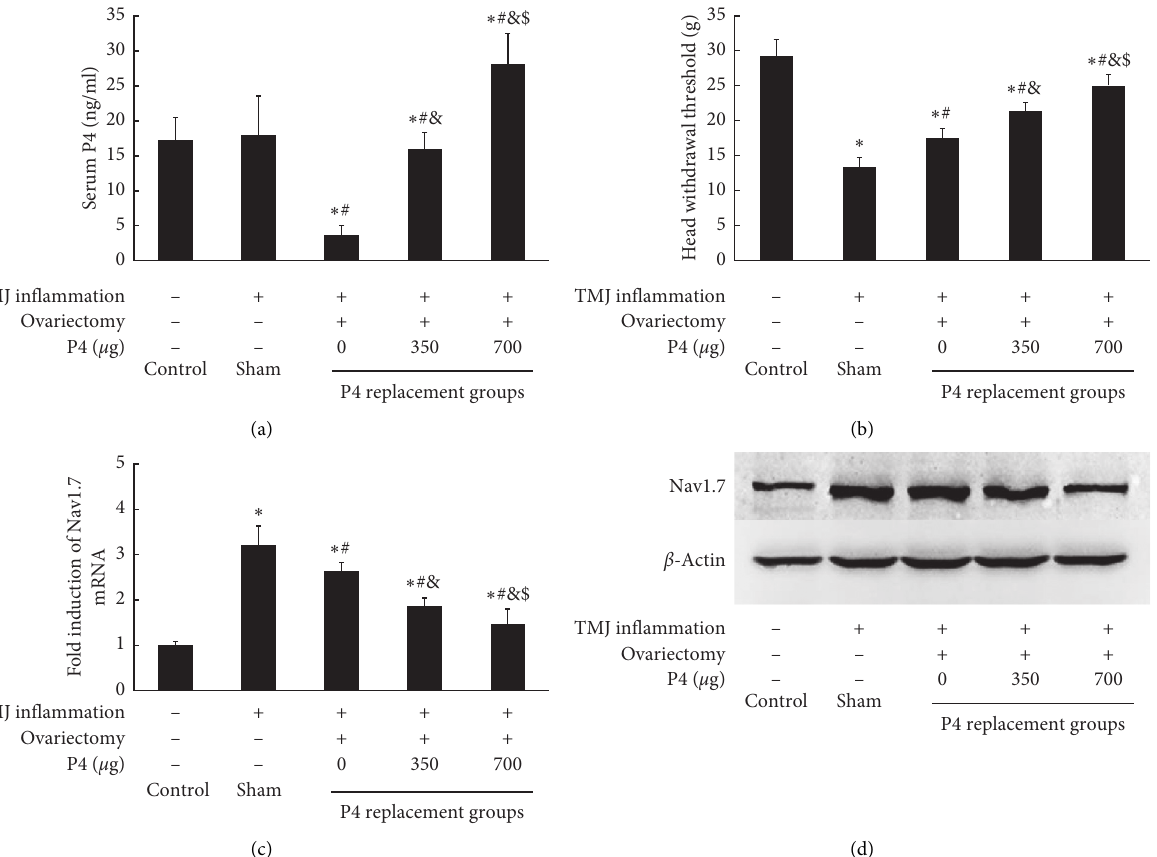
Figure 2: Progesterone attenuated TMJ inflammation-induced hyperalgesia and Nav1.7 expression. (a) Serum level of P4. Serum levels of P4 in the ovariectomized groups administered 0 μ g, 350 μ g, or 700 μ g P4 increased dose dependently. (b) Head withdrawal threshold. After induction of TMJ inflammation, the head withdrawal threshold was significantly decreased in sham rats and also dose-dependently increased in the ovariectomized groups. (c) Real-time PCR analysis for Nav1.7 expression in TG. The Nav1.7 mRNA in TG was increased by TMJ inflammation and attenuated dose-dependently by P4 in ovariectomized rats. (d) Representative immunoblotting for Nav1.7 ex- pression in TG. Nav1.7 protein expression corresponded to mRNA expression pattern. β -Actin served as an internal control for equal loading. ∗ P < 0 . 05 versus the control group; # P < 0 . 05 versus the sham group; & P < 0 . 05 versus the 0 μ g group; & P versus the 350 μ g group. Data are expressed as mean ±